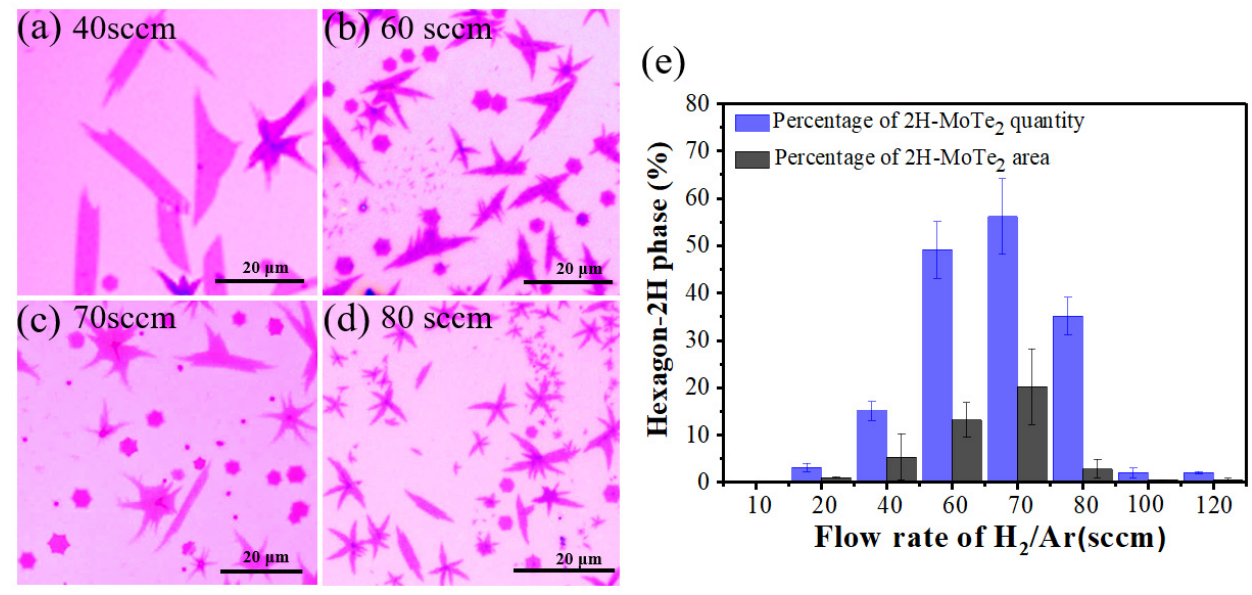
Figure 3. ( a – d ) Optical images of as-synthesized MoTe 2 under different gas flow rates, 40, 60, 70 and 80 sccm, respectively. ( e ) Dependence of 2H-MoTe 2 percentage in the quantity and area as a function of the gas flow rate which is positively correlated with the supply flux of Te.